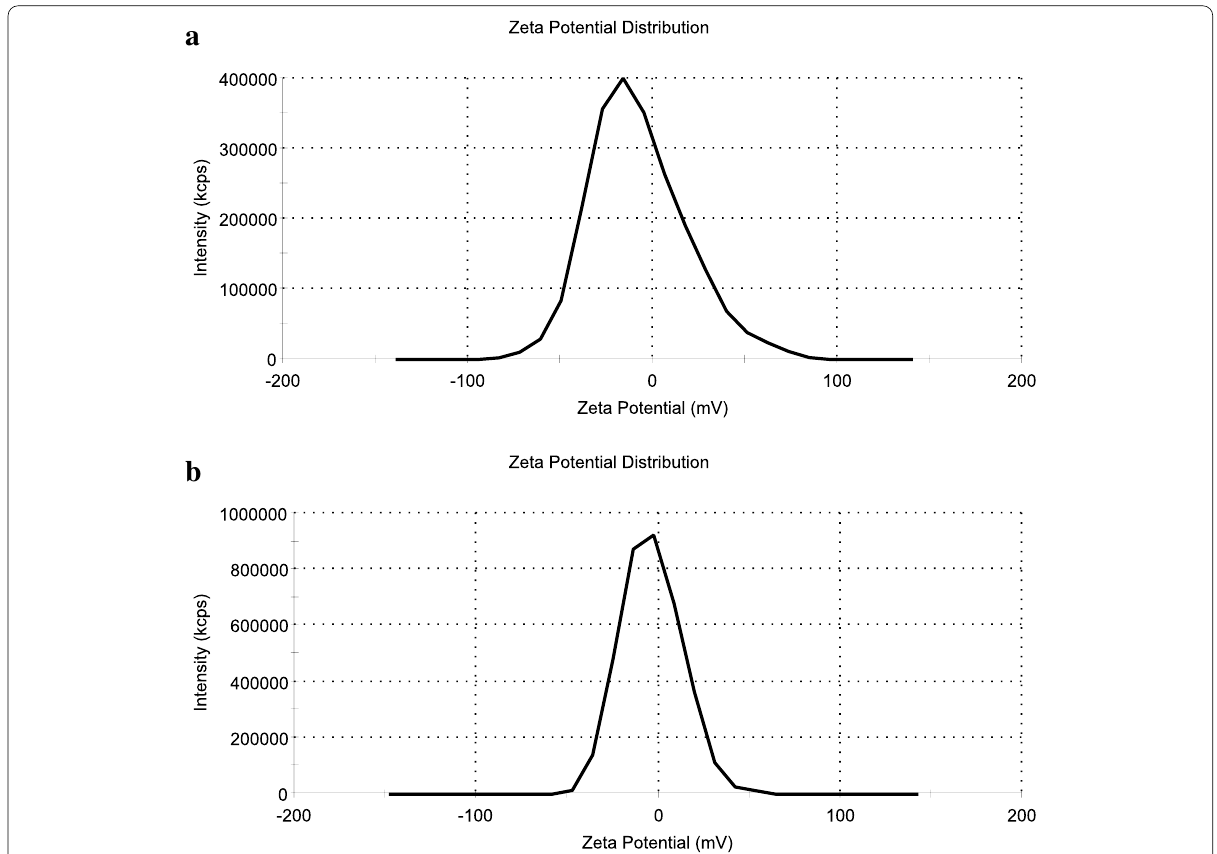
Fig. 3 Zeta potential diagram of a nettle and b fenugreek